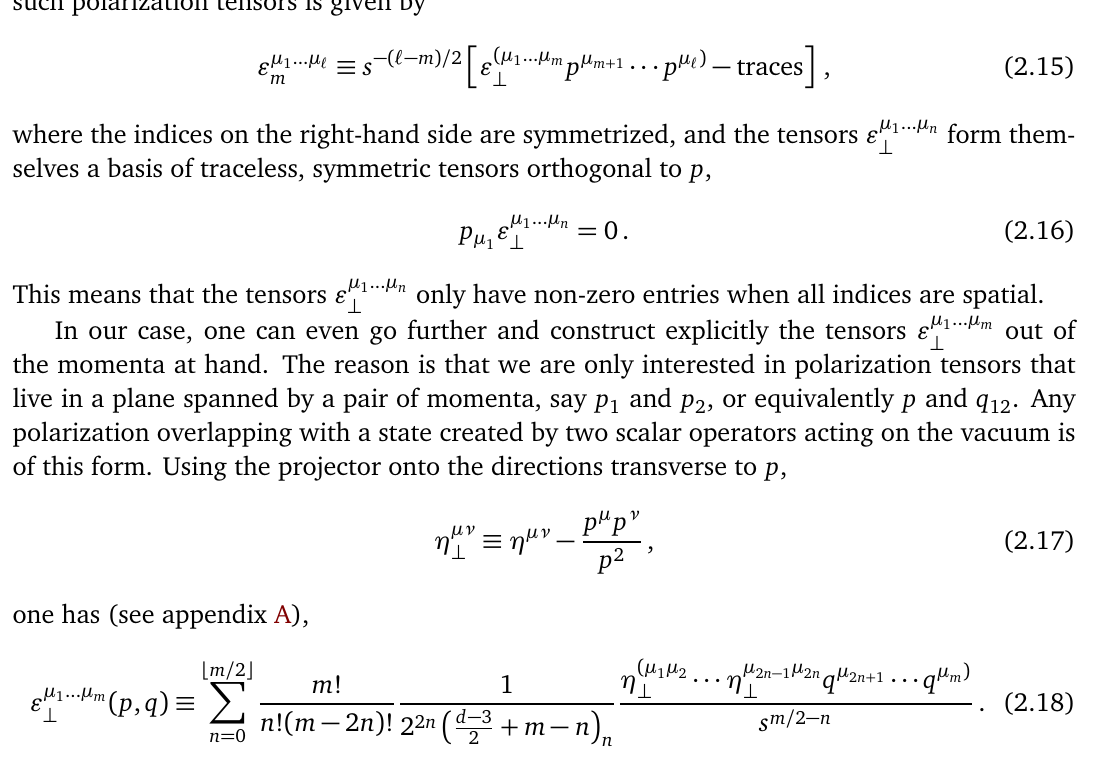
) and ( p ) , or equivalently between the vectors q , p , p 1 2 3 4 is time-like (backward directed), while p 1